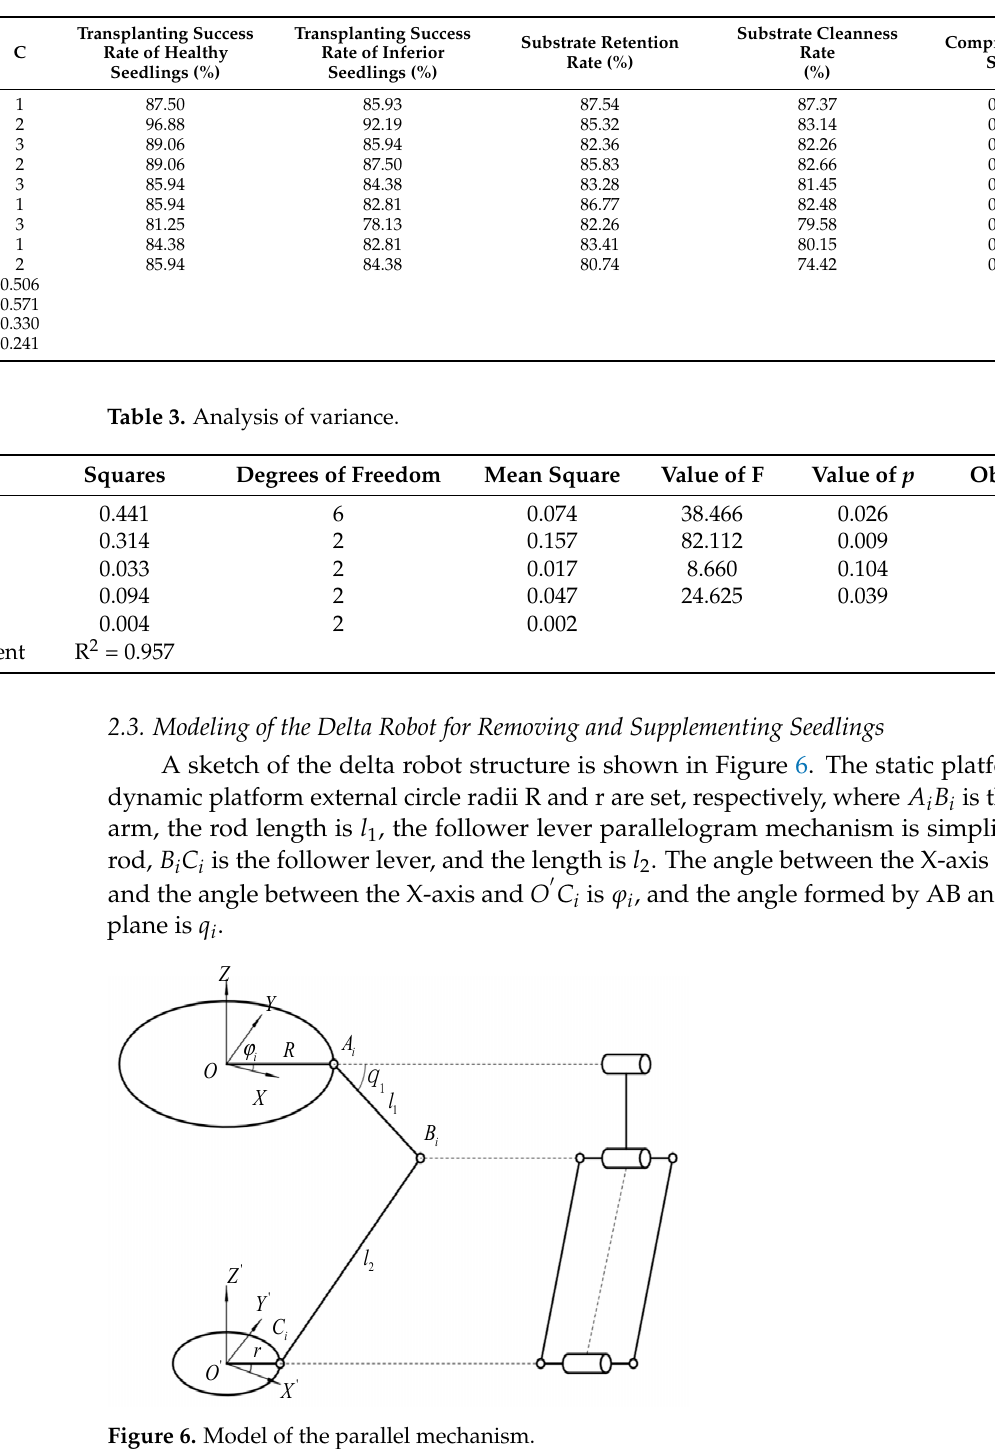
Figure 6. Model of the parallel mechanism.